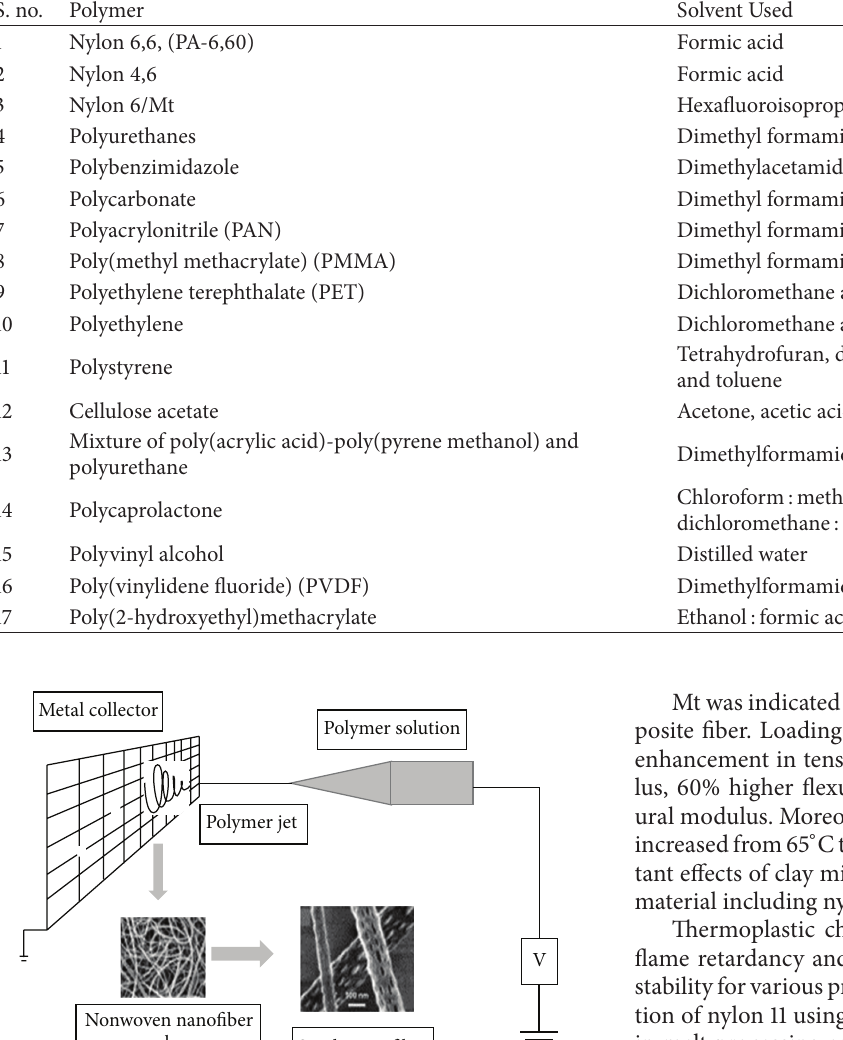
Table 2: Some important polymers and the solvent used in producing electrospun fibers [17].